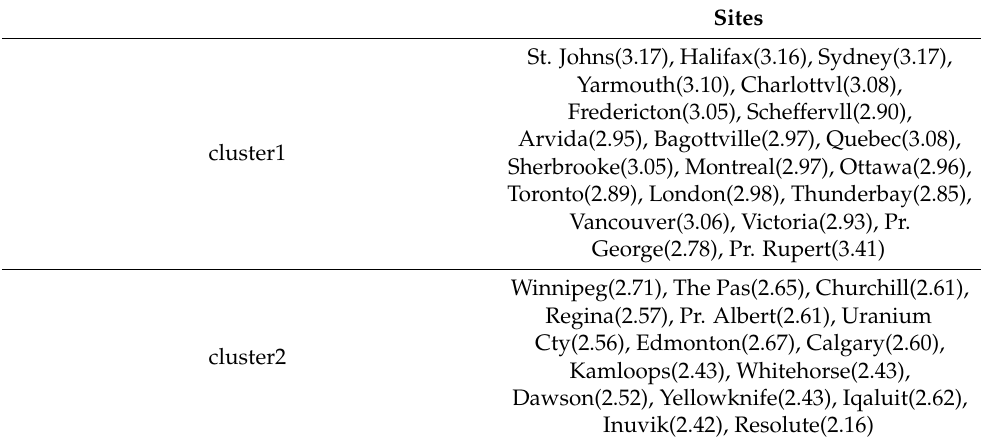
Table A3. Two clusters for the Canadian weather case by using the FCR-HL